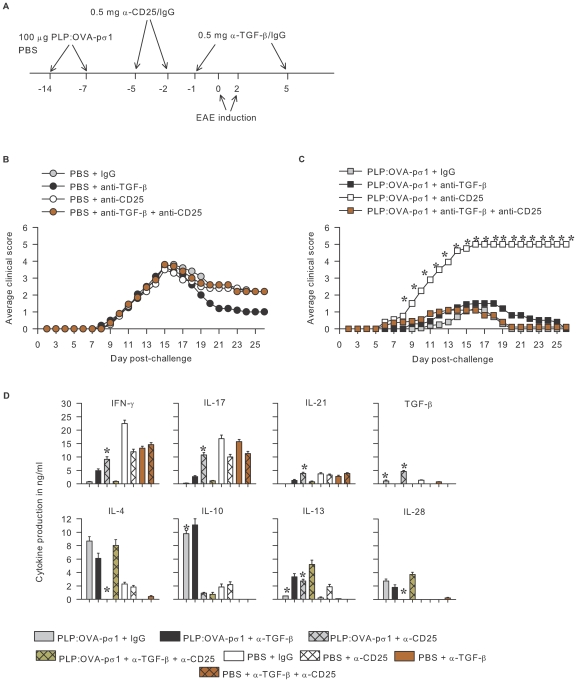
Abated protection against EAE in anti-CD25 mAb-treated PLP:OVA-pσ1-dosed mice is restored upon TGF-β co-neutralization.
A. Experimental design for neutralization of TGF-β and CD25. B. PBS-dosed mice, independent of treatment, developed expected course of EAE. C. Treatment with anti-CD25 mAb abrogated PLP:OVA-pσ1-mediated protection against EAE, but concomitant treatment with anti-TGF-β and anti-CD25 mAbs restored PLP:OVA-pσ1-induced protection. Mean of 10 mice per group is shown. B and C. * P<0.05 vs. IgG-dosed mice. D. HNLN CD4+ T cells on day 10 post-EAE induction were cultured with PLP139–151 peptide for 72 h. PBS-dosed mice independent of Ab treatment produced elevated proinflammatory cytokines IFN-γ, IL-17, and IL-21, and little to no IL-4, IL-10, IL-13, and TGF-β. However, levels of IFN-γ and IL-17 produced by CD4+ T cells were diminished in PBS + anti-TGF-β-treated mice when compared to PBS + IgG- treated mice. PLP:OVA-pσ1-protected mice treated with IgG, anti-TGF-β mAb, or anti-TGF-β + anti-CD25 mAbs produced enhanced IL-4 and IL-28, but minimal proinflammatory cytokines. Additionally, mice dosed with PLP:OVA-pσ1 + anti-CD25 + anti-TGF-β mAbs produced significantly more IL-13 and IL-4 than diseased PLP:OVA-pσ1 + anti-CD25-dosed mice. Mean + SEM of 5 mice per group is shown * P<0.05 for the PLP:OVA-pσ1 + anti-TGF-β + anti-CD25 vs. PLP:OVA-pσ1 + IgG and PLP:OVA-pσ1 + anti-CD25.